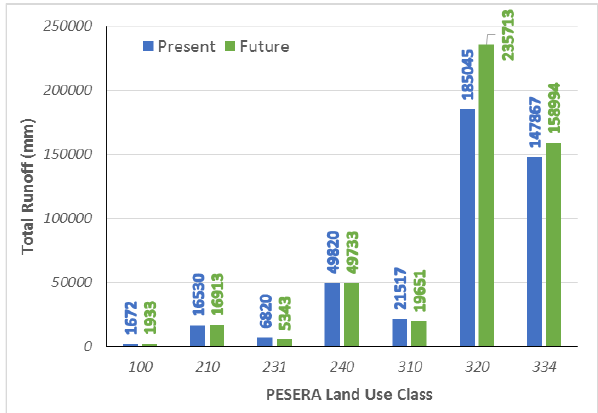
Figure 10. Total runoff of the PESERA land use classes of the Egribuk Subcatchment estimated with the PESERA